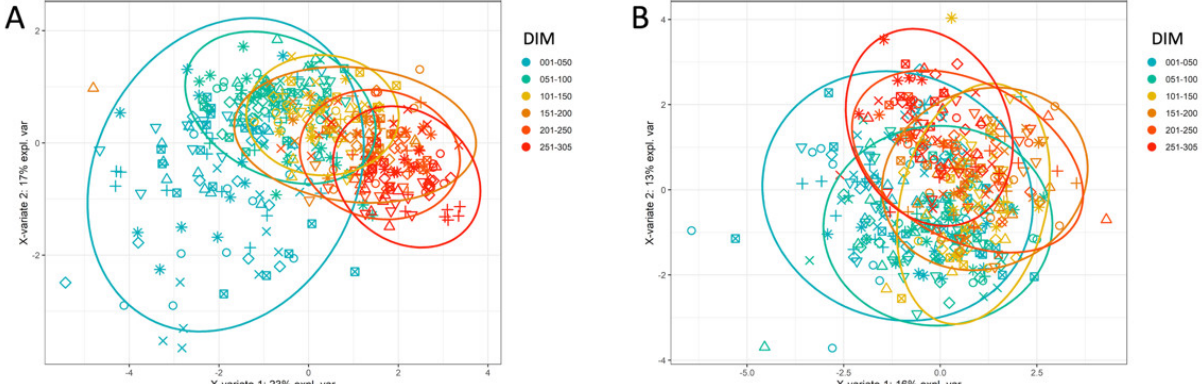
Figure 3. Results of different clustering methods, based on all measured parameters in the blood and milk. ( A ) PCA based on all parameters, shown here with the first principal component (PC1, 14.29% explained variance) and the second principal component (PC2, 10.79% explained variance). ( B ) sPLS-DA based on all parameters, shown here with the first component (X-variate 1, 14% explained variance) and the second component (X-variate 2, 9% explained variance). (AUROC values: phase “001–050 DIM” vs. others: 0.985; phase “051–100 DIM” vs. others: 0.895; phase “101–150 DIM” vs. others: 0.893; phase “151–200 DIM” vs. others: 0.864; phase “201–250 DIM” vs. others: 0.9148; phase “251–305 DIM” vs. others: 0.9893.)